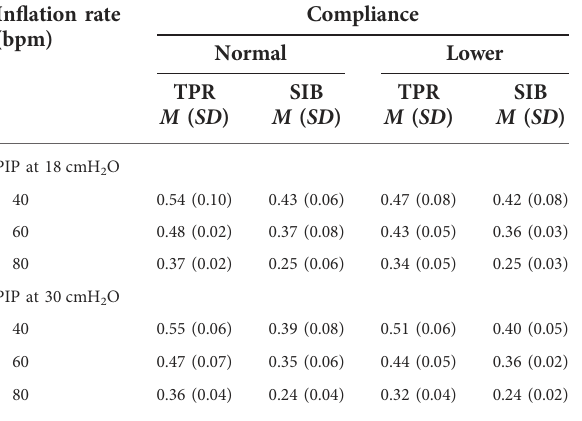
TABLE 3 Mean (SD) Ti (s) at variable in fl ation rates and PIP using TPR and SIB. In fl ation